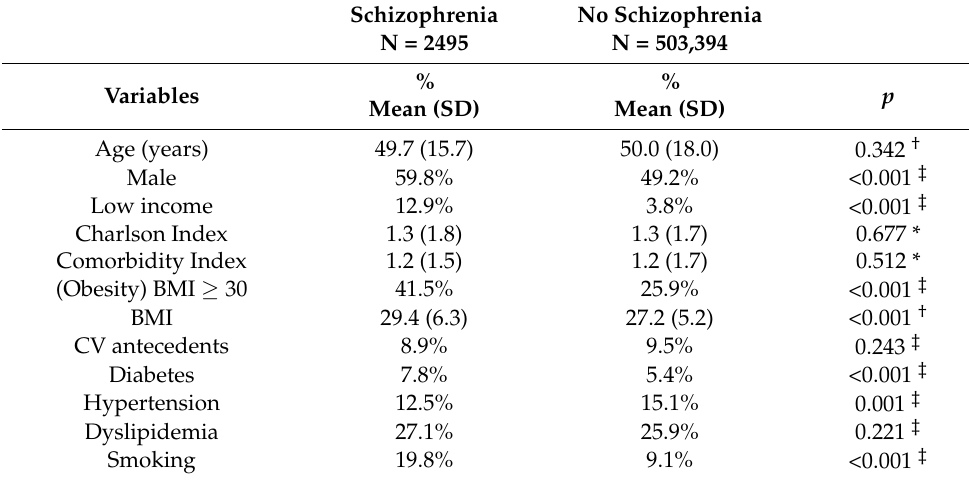
Table 1. Patients’